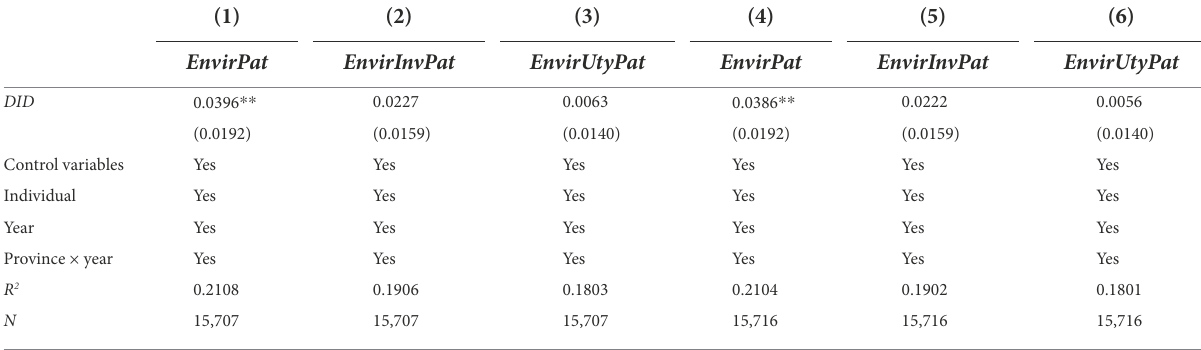
TABLE 4 Robustness tests: Reducing selection bias.